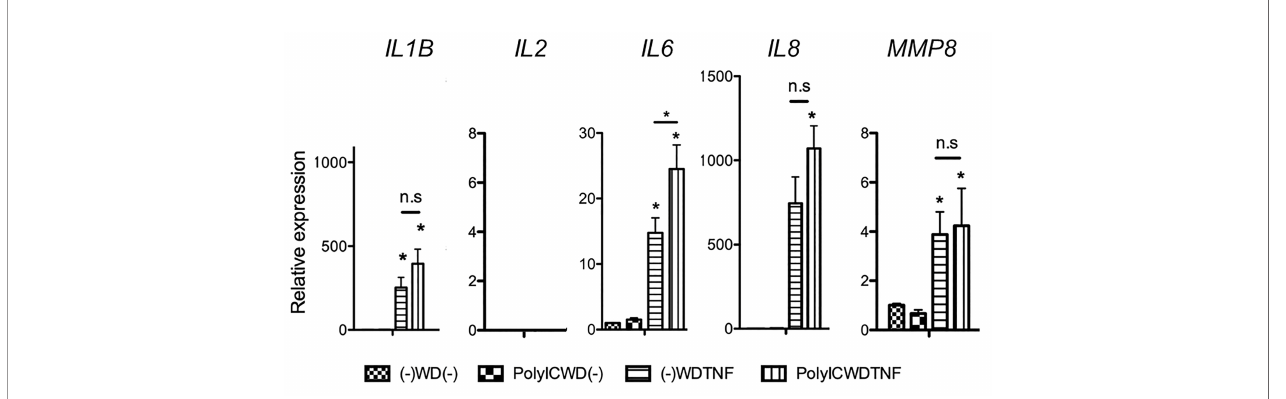
FIGURE 3 | Gene expressions after PolyIC – WD – TNF in HF19 cells. HF19 cells were initially treated with Poly (I:C) for 24 h and were then washed and rested for 24 h before secondarily treated with TNF a for another 24 h. Preexposure of HF19 cells to Poly (I:C) signi fi cantly increased TNF a -induced IL6 expressions (P < 0.05) but not IL1B , IL8 , and MMP8 . N = 3. Values with * were de fi ned signi fi cant when compared to (-)-WD-(-) while *above bar were signi fi cant between two variables; n.s means not signi fi